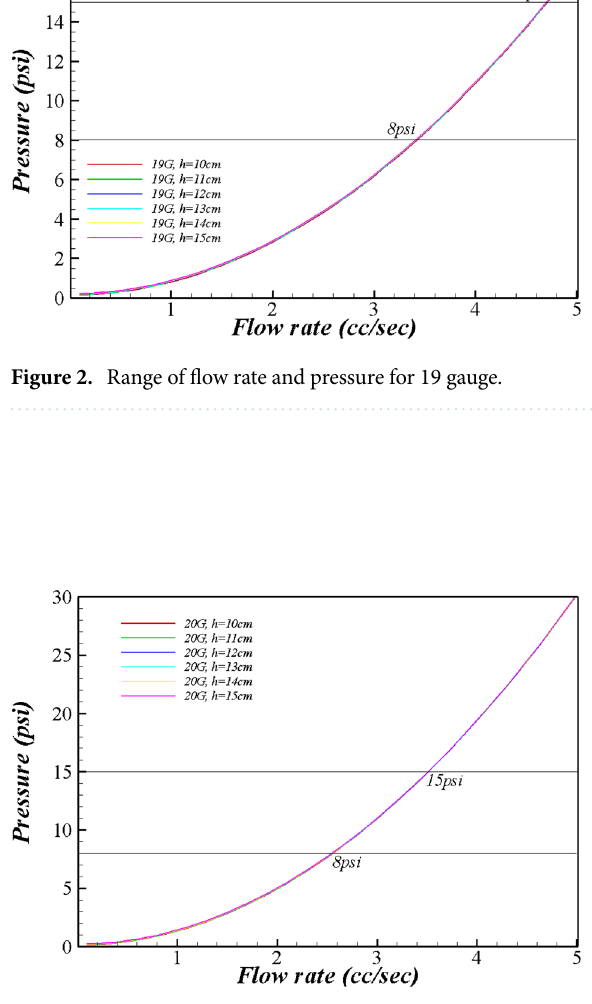
Figure 3. Range of flow rate and pressure for 20